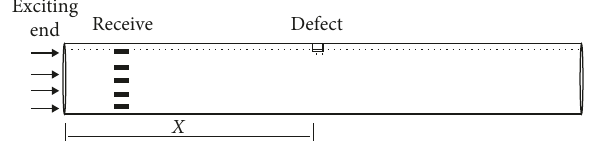
Figure 18: Schematic diagram of the calculation of the axial po- sition of the